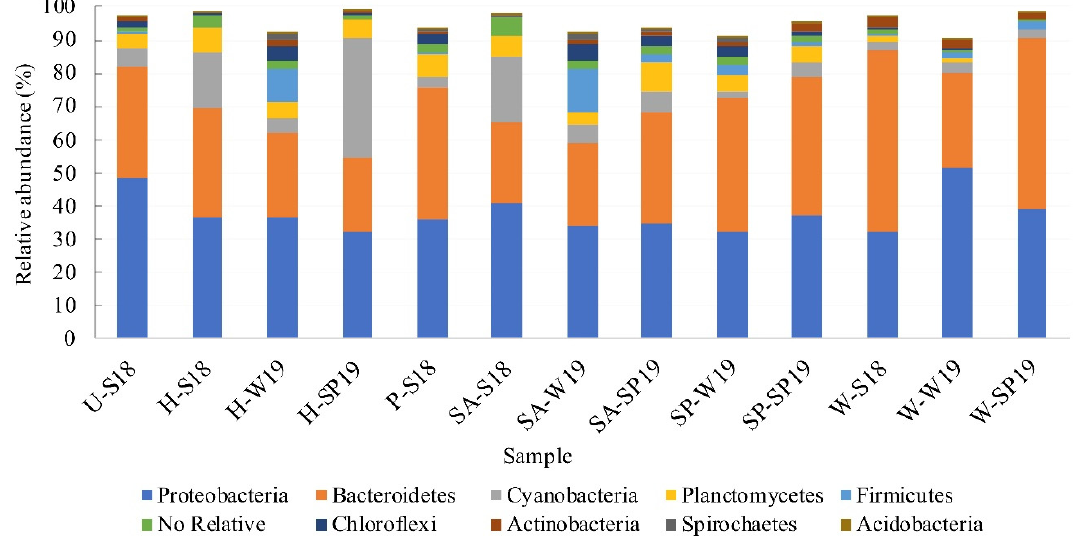
Figure A1. Taxonomic profile of top 10 prokaryotic taxa at higher level (phylum) across all samples. Top 10 represents 91% of the total sequences dataset. Codes: biofouling samples from the floating platform (H = non-planted holes and U = Under surface); biofilm samples from the planting media (SP = Spartina maritima ; SA = Sarcocornia perennis ; and P = Phragmites australis ) and water samples (W); S18 = Summer of 2018; W19 = Winter of 2019 and SP19 = Spring of 2019. Table A1. SIMPER analysis results displaying top 10 genera responsible for the dissimilarity and the contribution percentage for that dissimilarity between water samples and biofilm samples from the planting media Taxa (Genera) Mean Abund. Plants (%) Mean Abund. Water (%) Contrib. (%) 0.04